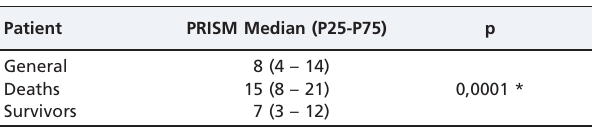
Table 2 – PRISM comparison between patients who died and survivors